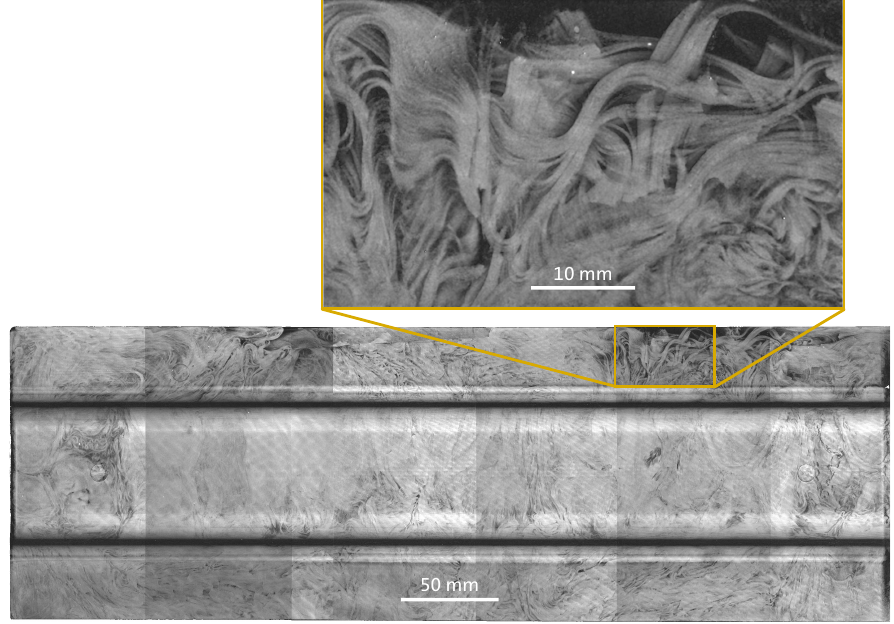
Figure 21. CT scan of sample #20 showing fiber bundles of split UD strands on the surface of the hat profile’s end brim after a flow length of approximately 100 mm.